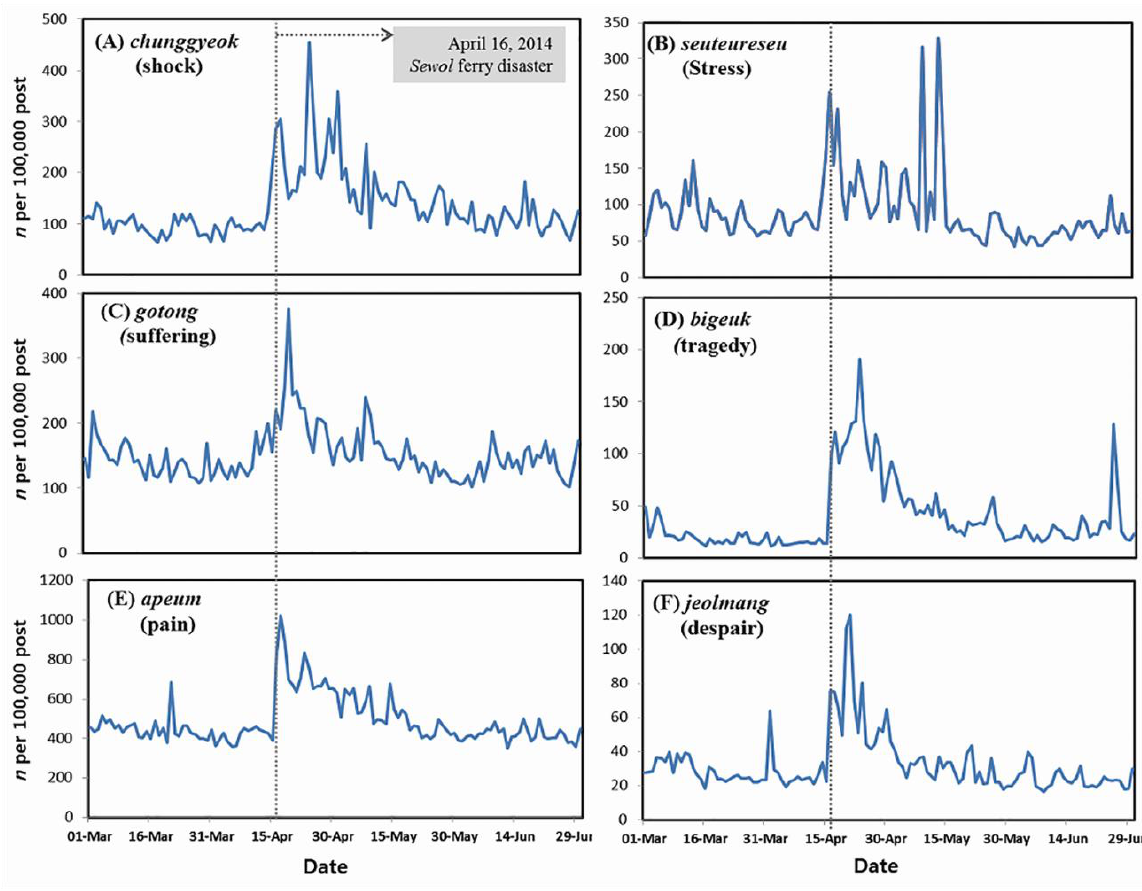
Figure 4. The Sewol ferry disaster and suicide-related public